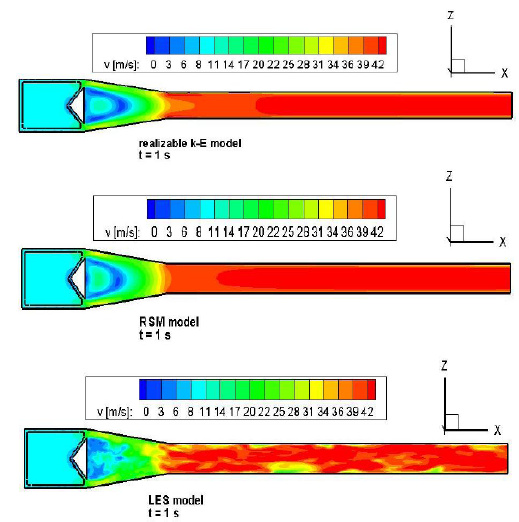
Figure 8. Velocity distribution along the chamber axial cross-section for the three turbulent models for t=0.5 s.